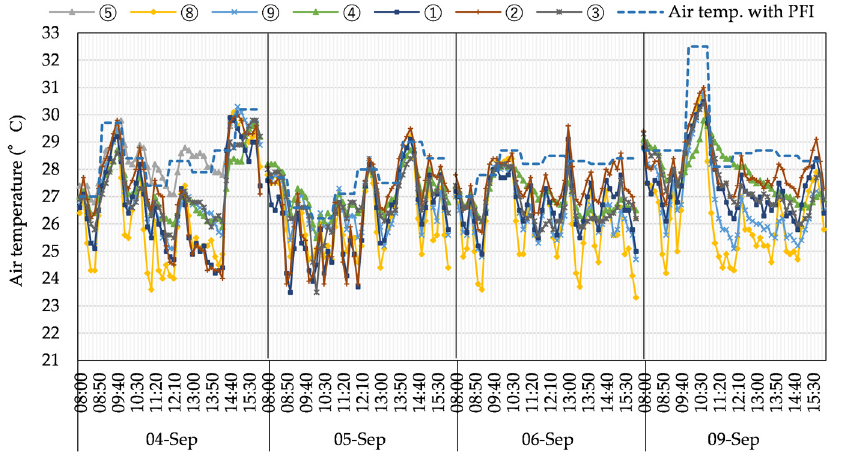
Figure 10. Summer air temperature for class C.